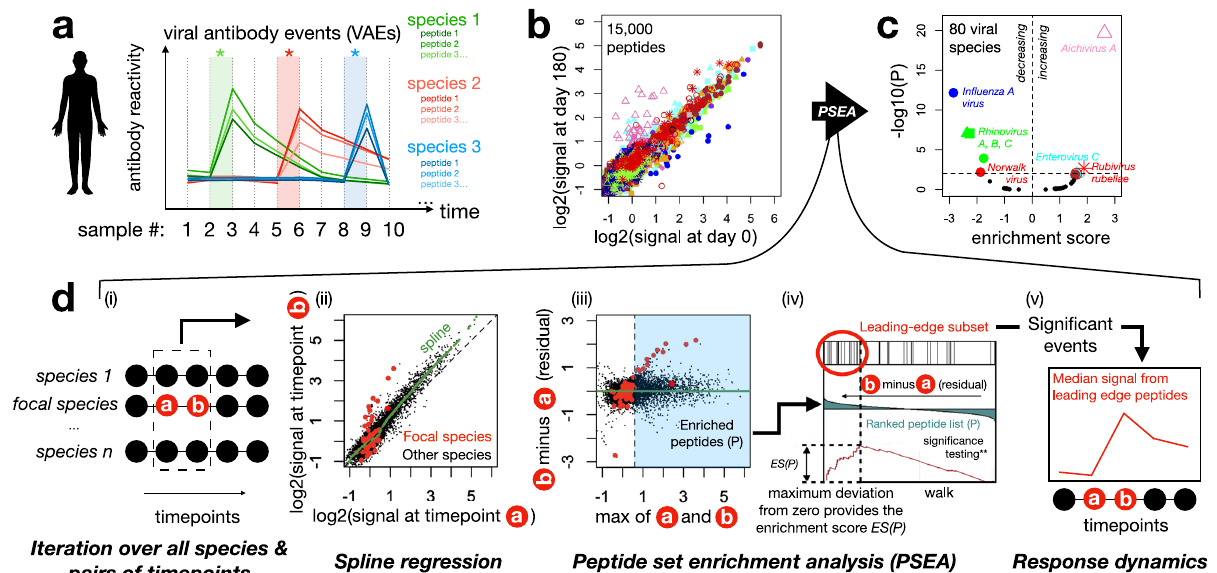
Fig. 1 | Virus-speci fi c events inferred from co-ordinated temporal changes in highly-multiplexed antibody reactivity data. a Conceptual fi gure showing how viralevents — corresponding to infectionsorreactivations — appearinalongitudinal series of multiplexed antibody reactivity data. b , c Example plots showing the transformation of peptide-level signals ( b ) into species-level signals ( c ) from two consecutive timepoints from an individual participant, separated by 180 days: ( b ) showsthemagnitudeofreactivityateachtimepointagainst15,00030merpeptides in the HV2T human virome library, each peptide is represented by a dot whose color and shape re fl ect its species of origin, while ( c ) shows the change in species- level reactivity to each of the 80 virus species covered in HV2T, expressed as an EnrichmentScore(x-axis:positive=increasingovertime,negative=decreasingover time)andadjusted p value(y-axis).Thedatashownin( c )werecalculatedusingthe algorithm described in ( d ). Species with adjusted p <0.01 are highlighted, using symbolsmatching( b ). d Todetectviralevents,ouralgorithmconsiderseachpairof